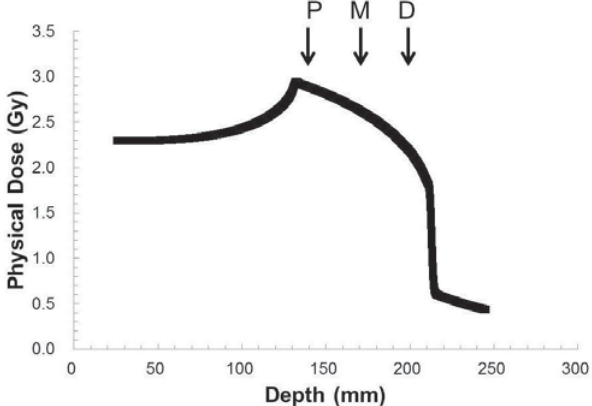
Figure 5. Physical depth-dose distribution of carbon ion beams. Depth-dose distribution of carbon ion beams with 80 mm spread-out Bragg peak (SOBP). Arrows indicate three positions of cells irradiated with carbon ions. Human salivary gland tumor cells were irradiated at position P (30 mm upstream), D (30 mm downstream) of middle position